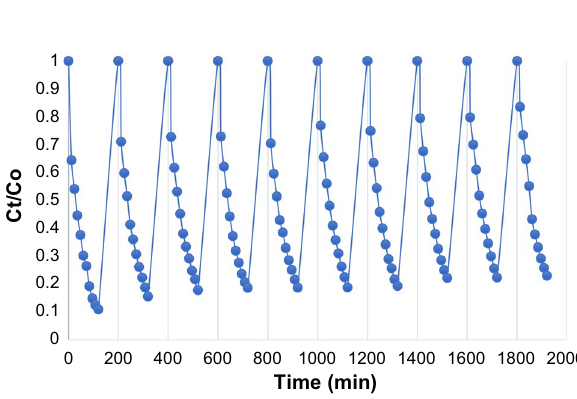
Table 6 Apparent kinetics ( K